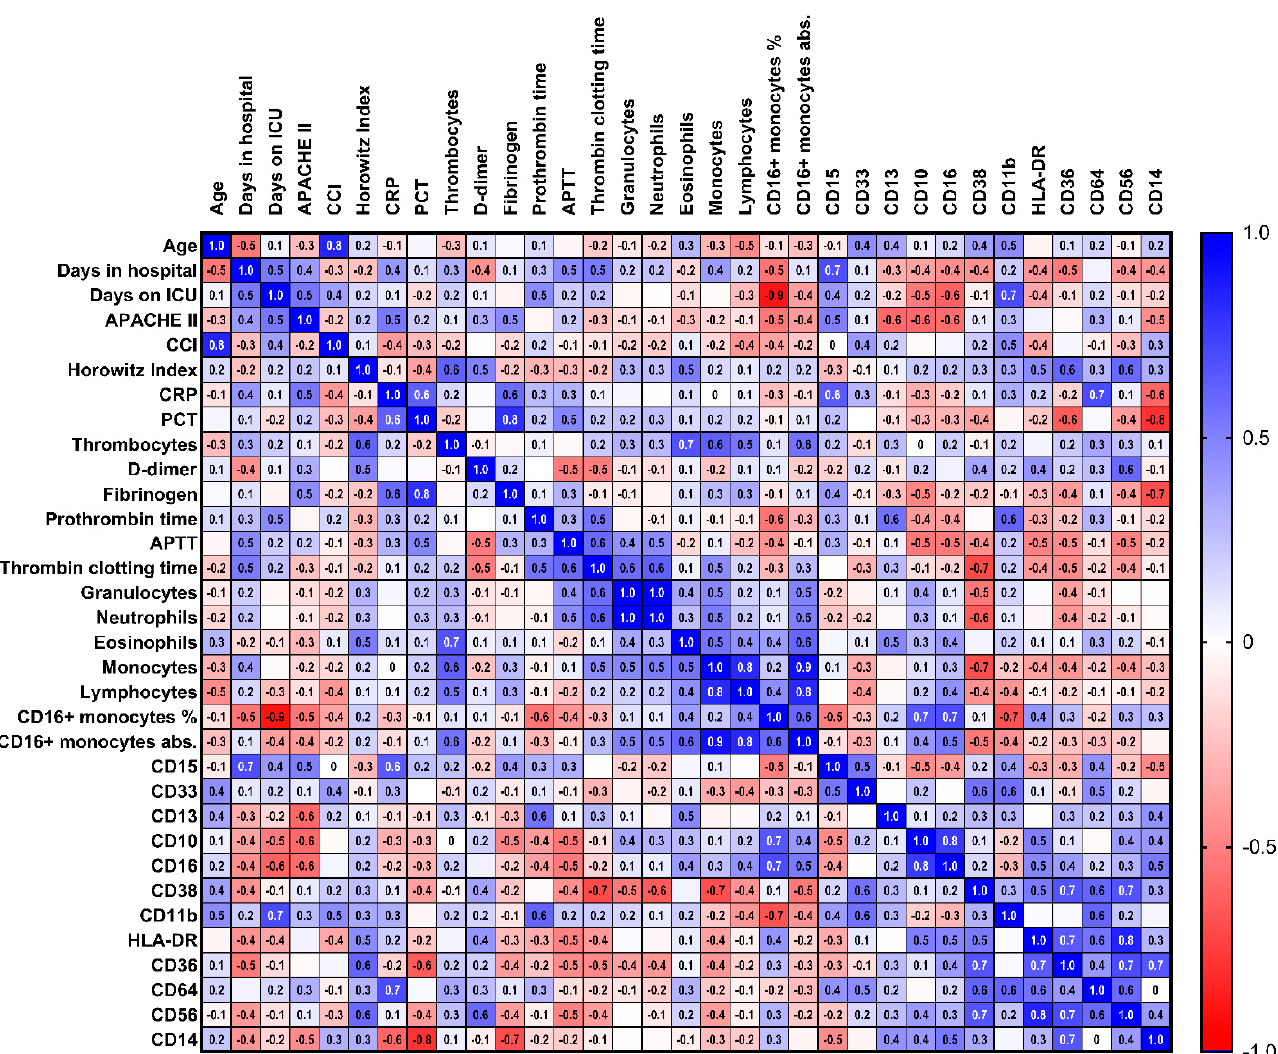
Figure 5. Correlation matrix of the monocytes and clinical parameters. Correlation matrix (heat map) of the immunophenotypic characteristics of the monocytes and clinical parameters of patient with COVID-19 in the ICU ( n = 12). Spearman’s ρ ranks between ± 1.0 (dark blue, dark red), high (inverse) correlation, and ± 0 (white), no correlation (abbreviations: ICU = intensive care unit; n = number; APACHE = acute physiology and chronic health evaluation; CCI = Charlson comorbidity index; CRP = C-reactive protein; PCT = procalcitonin; APTT = activated partial thromboplastin time; SSC = side-scatter).